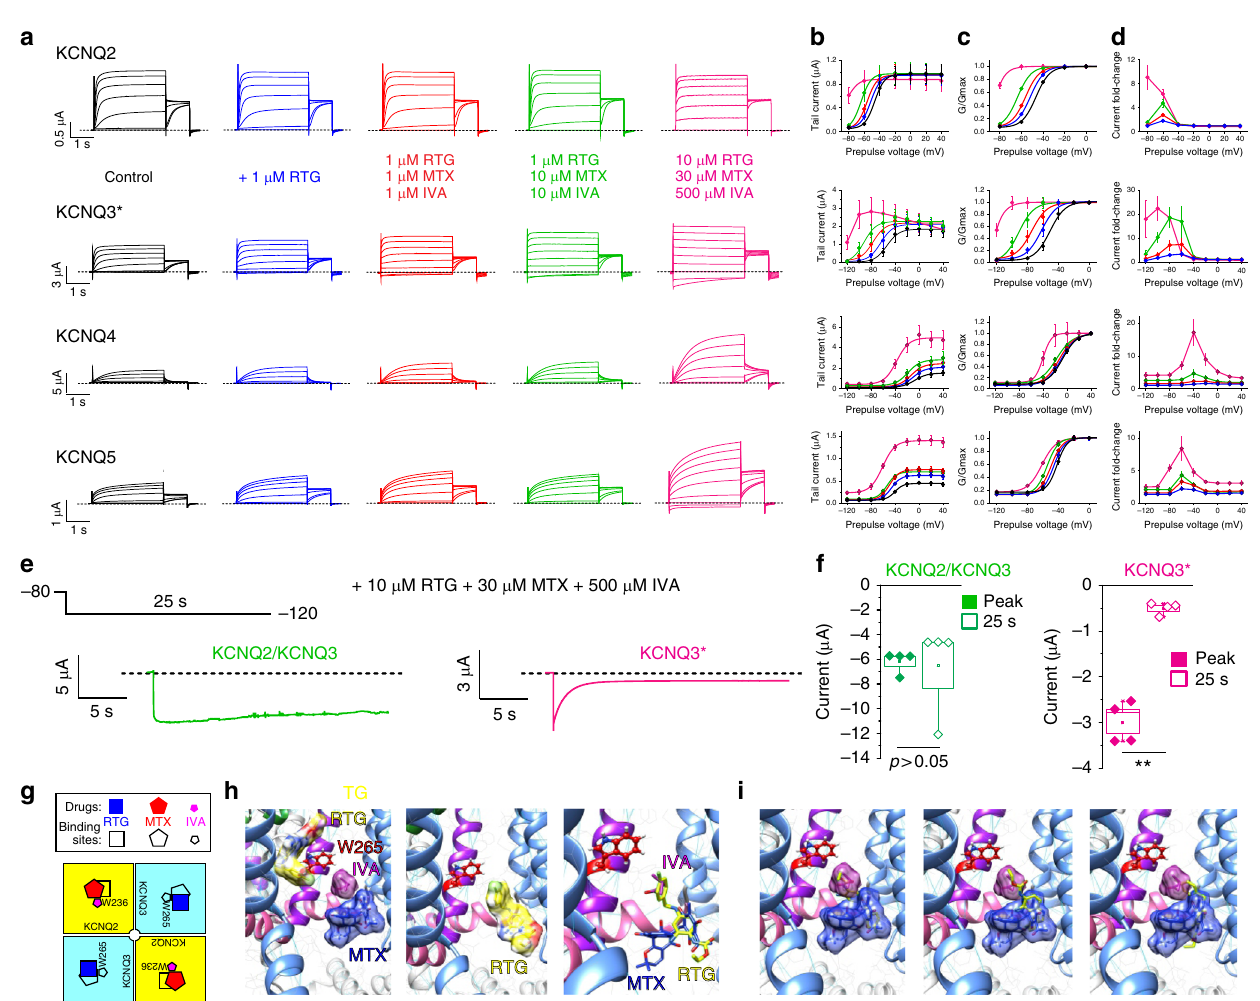
Fig. 9 Leveraging heteromeric channel composition to lock open KCNQ2/3. a Averaged traces showing effects of RTG, IVA, and MTX alone or in combination, doses as indicated, on homomeric KCNQ2 – 5 channels ( n = 4 – 11). Voltage protocol as in Fig. 1d. b – d Analysis of traces as in a : b tail current; c G / G max ; d current fold-change versus voltage; compounds and combinations color-coded as in a . n = 4 – 11. e , f Effects of high-dose RTG + MTX + IVA on KCNQ2/3 versus KCNQ3* held at − 120 mV for 25 s. e Representative traces; f mean peak (0.5 s) versus steady-state (25 s) current. ** p < 0.01; n = 4. Box and whisker plots: box range, SEM, coef fi cient of 1; whisker range 5 – 95%, coef fi cient of 1.5. g Model summarizing fi ndings. Squares represent subunits within tetrameric KCNQ2/3 channels ( yellow , KCNQ2; pale blue , KCNQ3). h Possible distinct binding positions of RTG, IVA, and MTX in one binding site in KCNQ3 (left) versus a lower-positioned RTG binding site (center) that would overlap with binding sites for IVA and RTG (right), predicted by SwissDock using a chimeric KCNQ1 – KCNQ3 structure model. Red , KCNQ3-W265; magenta , IVA; blue , MTX; yellow , RTG. Space- fi lling omitted from molecules in right panel for clarity. i Further possible poses RTG ( yellow, no space fi ll ) that would overlap with IVA ( magenta ) and MTX ( blue ) in KCNQ3 chimera model as predicted by SwissDock. All error bars indicate SEM. All comparisons by one-way